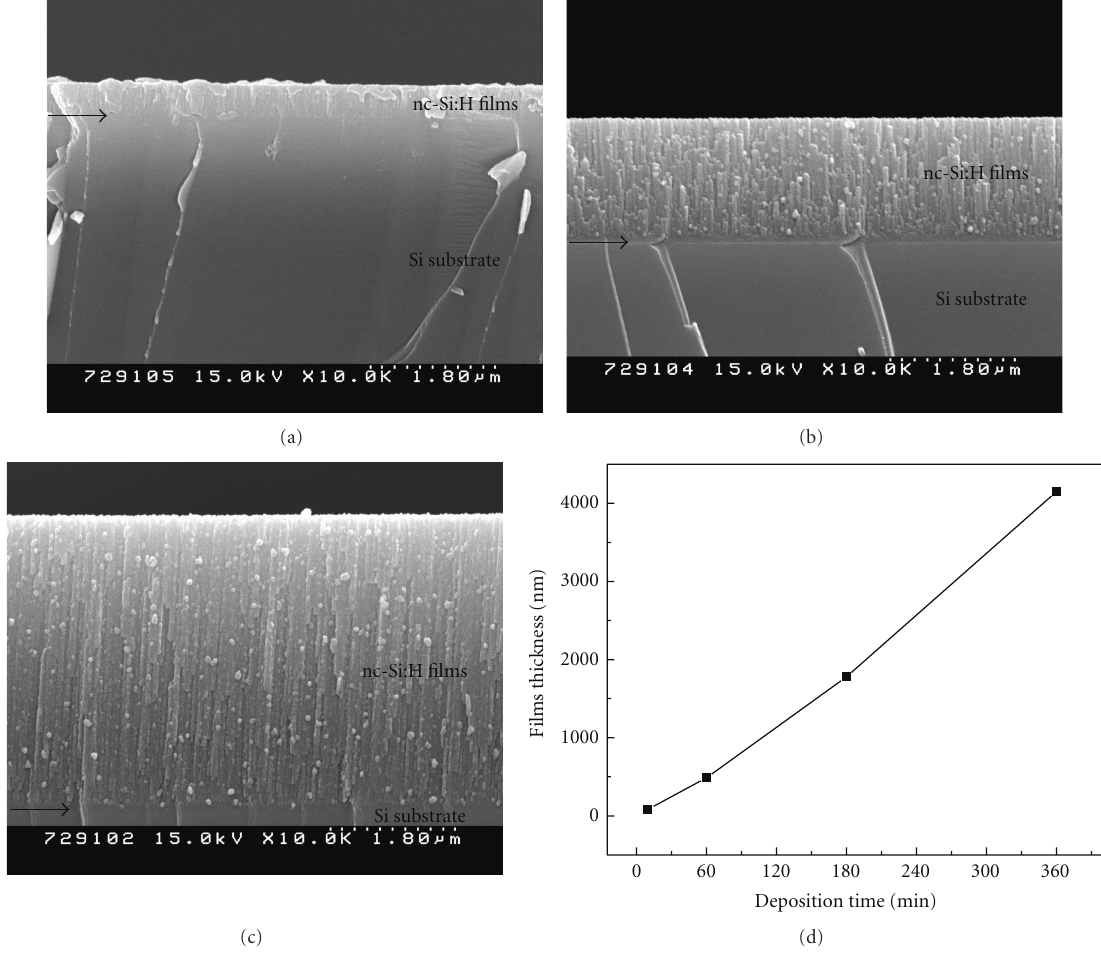
Figure 1: Cross-section SEM images of the films. The films were prepared for 60 (a), 180 (b), and 360min. (c), respectively. (d) Film thickness versus deposition time. The arrows indicate the interface between the films and Si substrate.